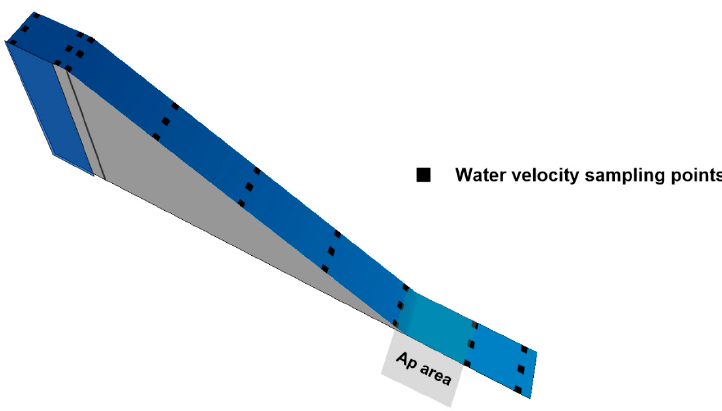
Figure 3. Location of the water velocity sampling points. Measurements were taken along 3 longitudinal planes—at the center of the ramp, and 2 lateral planes spaced 0.05 m from the walls. Points were distanced 0.75 m along the ramp, and 0.50 m upstream and downstream (0.50 m and 1.00 m) of the ramped weir. Water velocity at the middle of the weir crest was also measured.